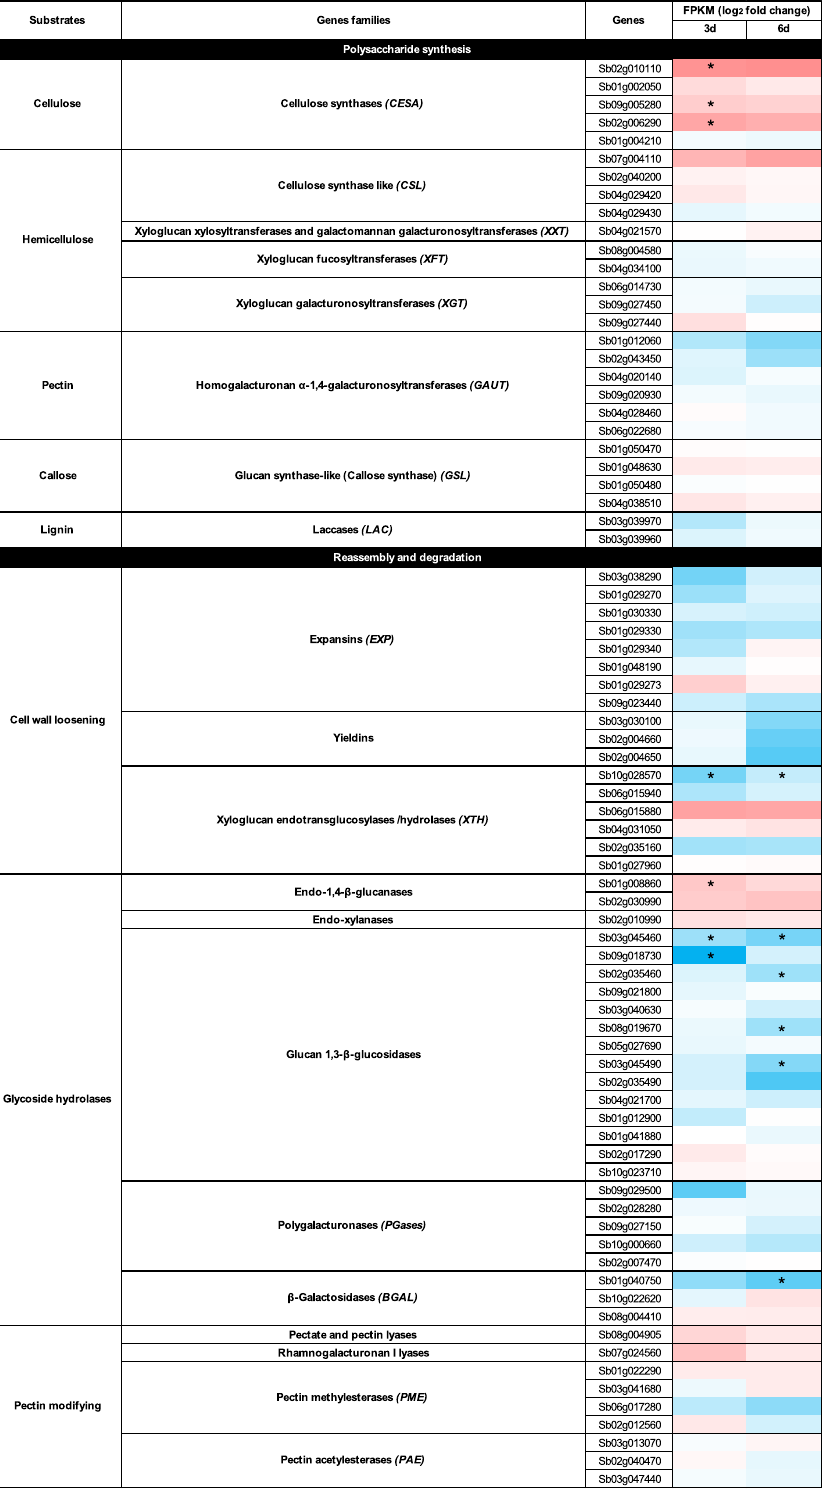
Figure 3. Heatmap showing the change in expression of known cell wall-related genes in hydroponically- grown sorghum seedlings in response to low-N condition at 3 and 6 days after treatment. The log 2 values of the fold change (low-N/control) are shown. Asterisks indicate significant difference between treatments (n = 3, q -value <